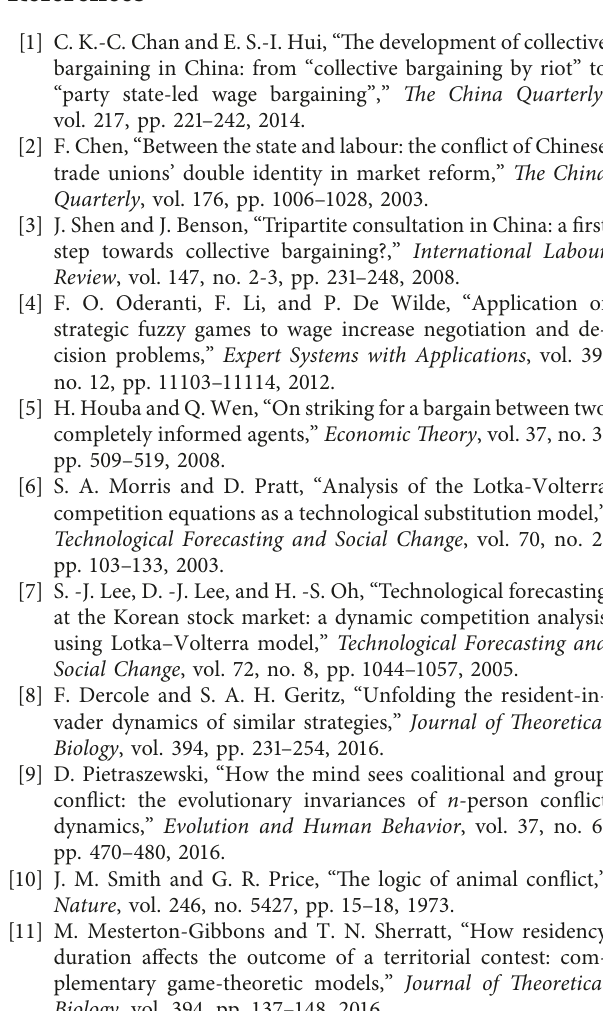
simulation result is illustrated in Figure 8(a), and the phase trail is shown in Figure 8(b).